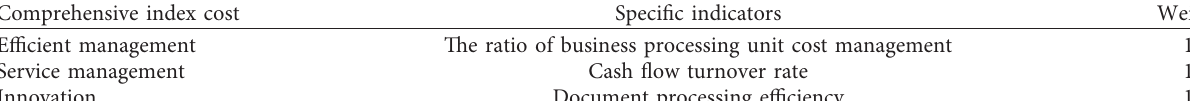
Table 1: Assessment indicators.